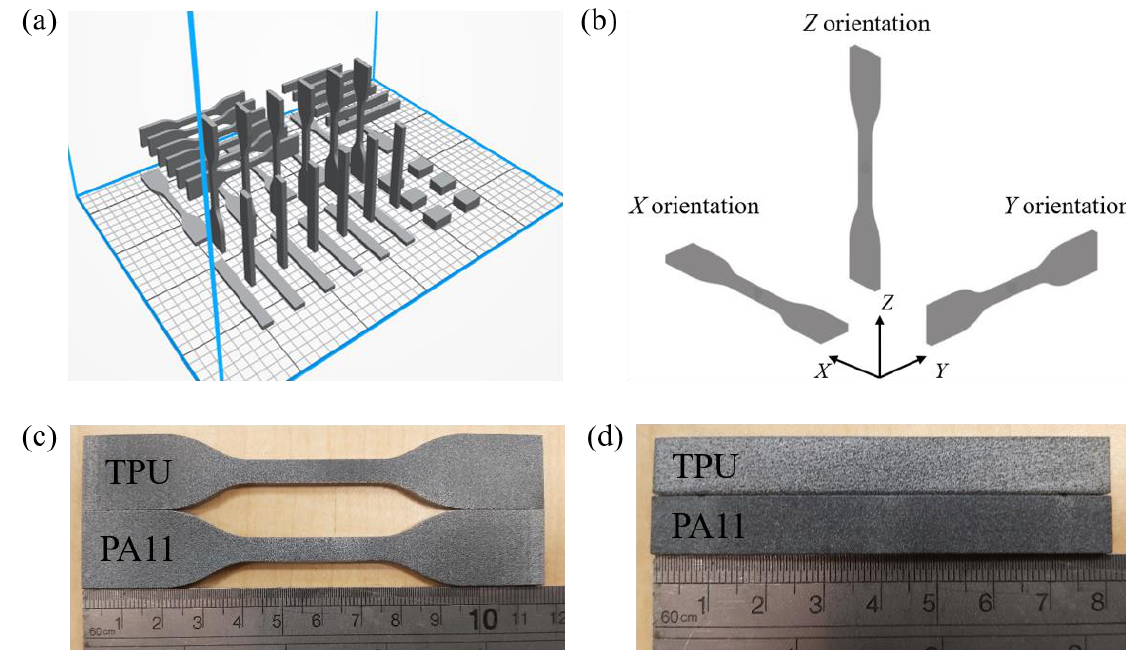
Figure 1. Design and fabrication of MJF-printed specimens: ( a ) print layout, ( b ) build orientation axes in accordance with ISO/ASTM 52921, ( c ) tensile bars and ( d ) flexural bars.